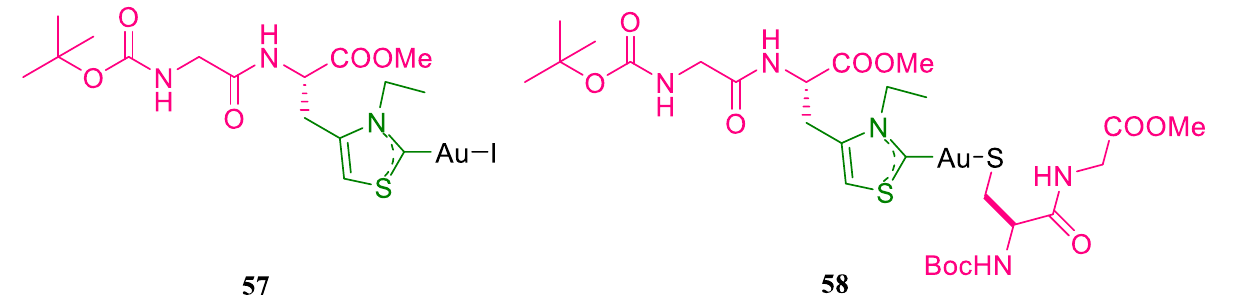
Figure 52. Au I N and S-heterocyclic carbenes (NSHC)-derived peptides. Ibrahim M A et al. synthesised amino acid conjugated metronidazole, sulphadiazine